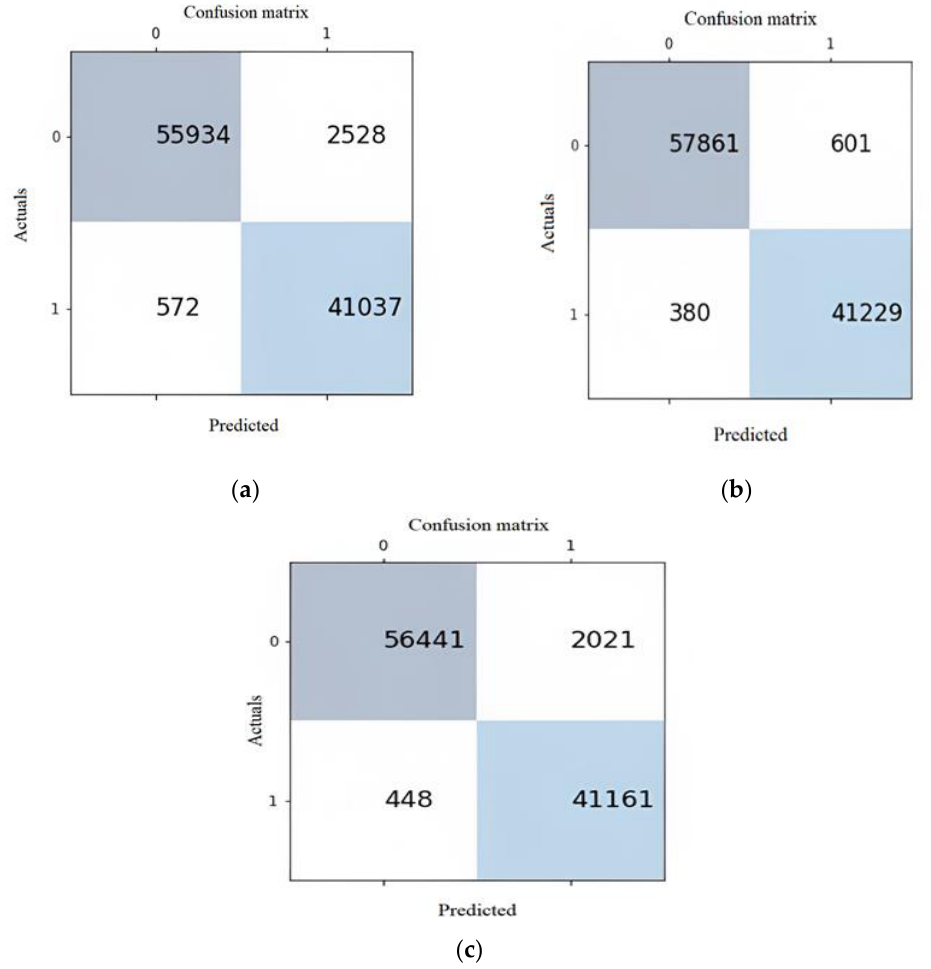
Figure 6. Confusion matrices for LSTM ( a ), Bi-LSTM ( b ), and GRN-based RNN algorithm ( c ).